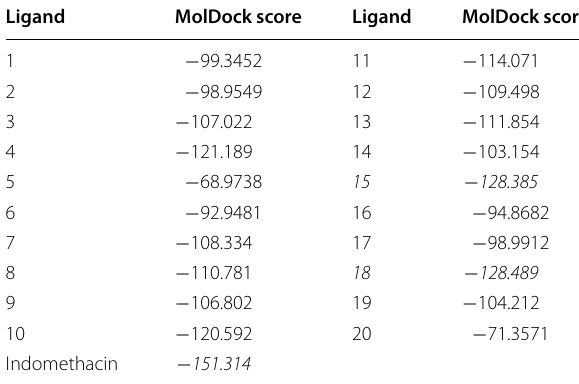
Table 3 MolDock scores of tested compounds Ligand MolDock score Ligand MolDock